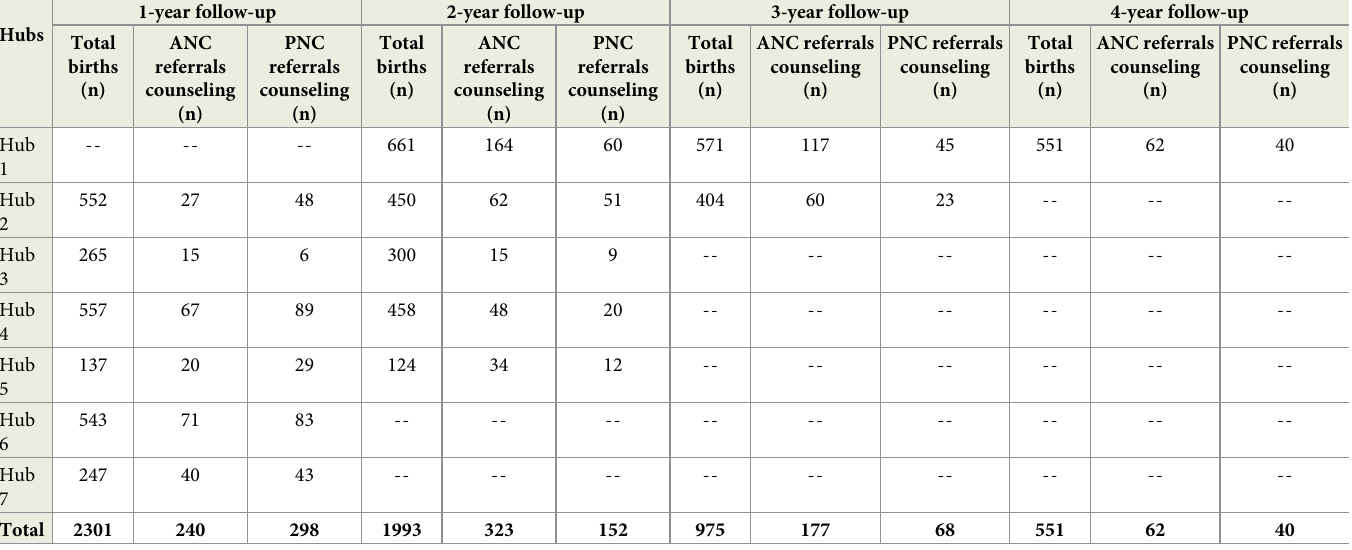
Table 4. Total antenatal and postnatal immediate referrals made for high risk conditions.